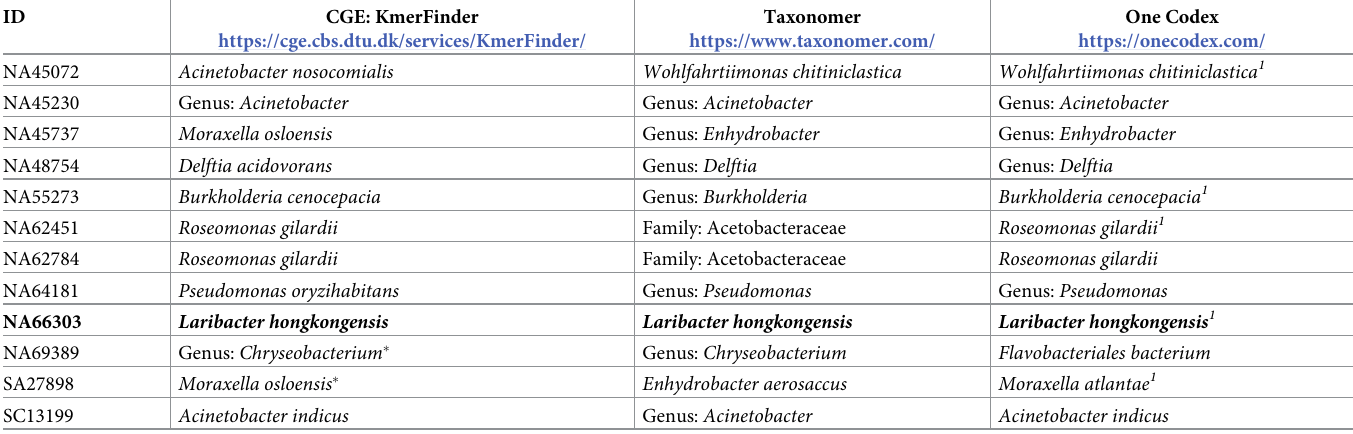
Table 3. Summary of isolate identification using 3 different web-based platforms on whole genome sequencing short read raw data files.